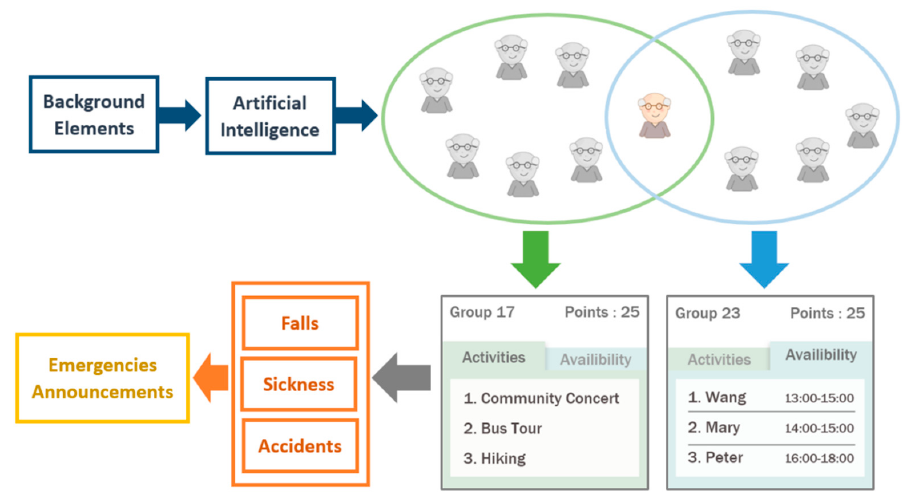
Figure 4. The Prototype System of Long-term Care.